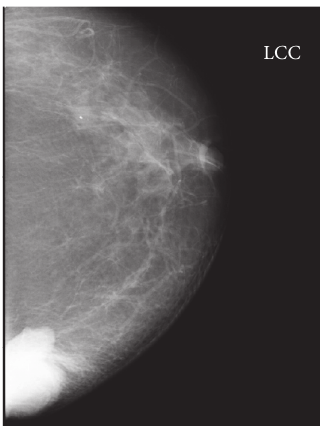
Figure 1: 59-year-old woman with left breast mass. CC mammo- gram shows dense mass with sharply defined, lobulated contours, located at the inner part of the left breast.